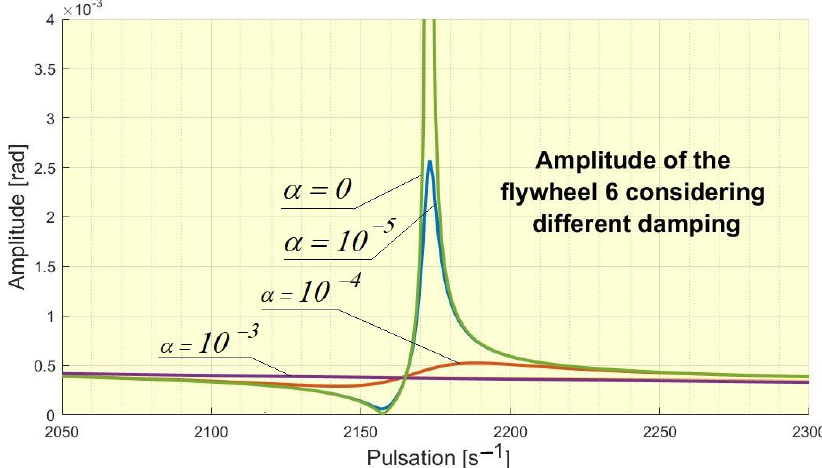
Figure 14. Effect of damping on the amplitude of the flywheel 6.